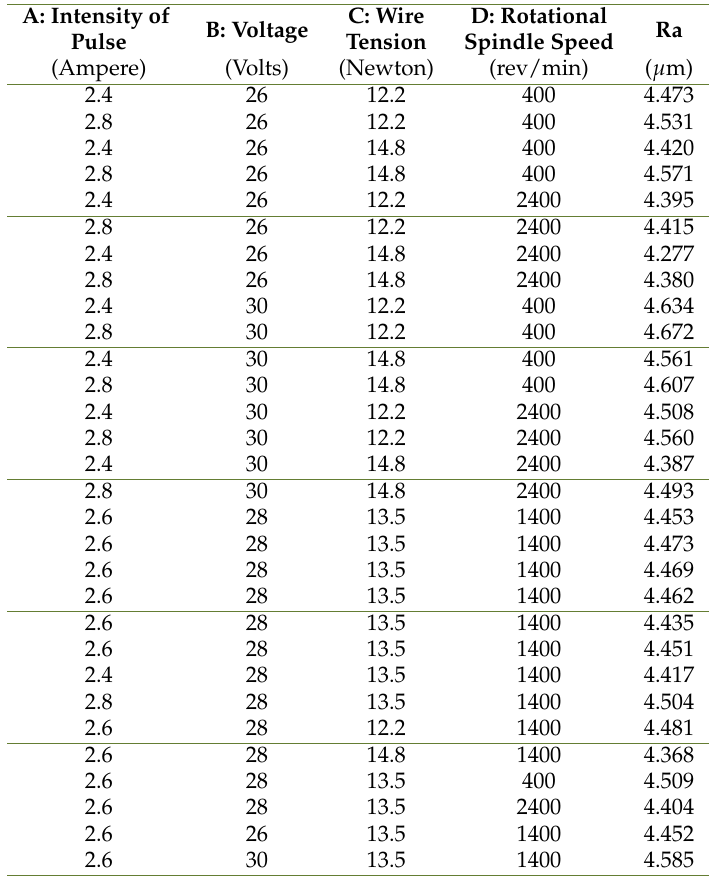
Table 3. Design matrix generated by face-centered central composite